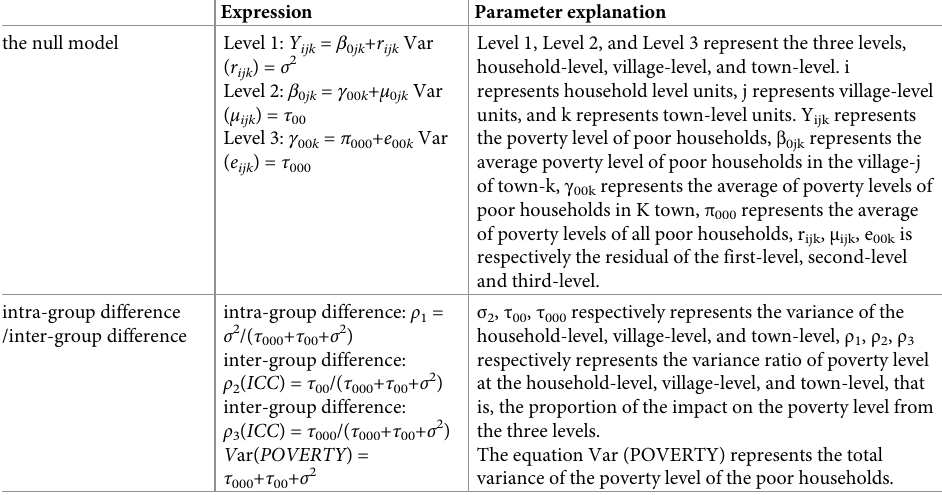
Table 2. The calculation formula of the null model and ICC